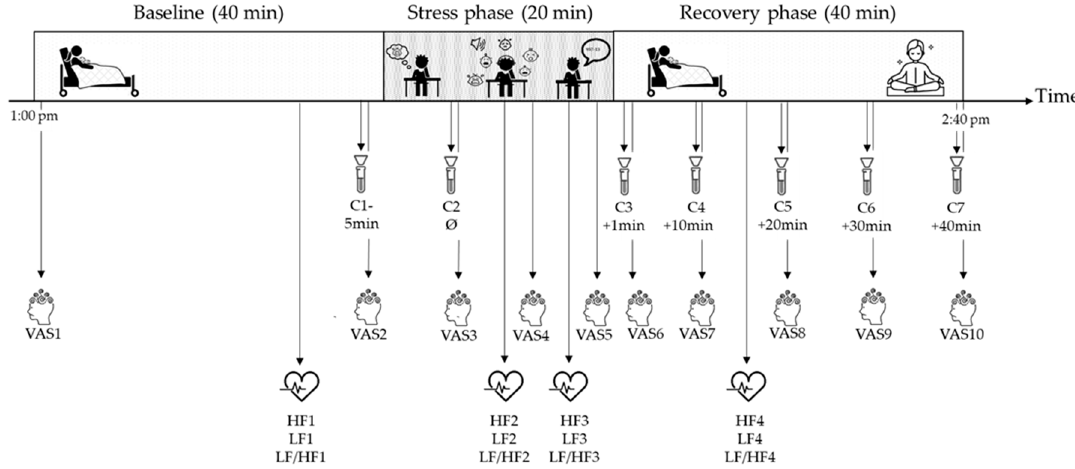
Figure 1. The procedure of the Lausanne Infant Crying Stress Paradigm contains a baseline phase and recovery phase, in which participants rest in their hospital room with their baby, as well as a stress phase, in which participants complete three stressful tasks (i.e., 3 min anticipation of the infant crying test, the infant crying test, and a surprise mental arithmetic task) in a consultation room. At the end of the recovery phase, an optional guided relaxation is offered to participants. Salivary cortisol assessments are represented by salivette icons, with the 1st salivary sample (C1) taken 5 min before the beginning of the stress phase, the 2nd salivary sample (C2) taken after the 3 min anticipation before the psychosocial and cognitive stressors, and the 3rd to 7th salivary samples (C3–C7) taken after the stress phase at 10 min interval. Perceived stress is illustrated with the head icon, measured 10 times via a visual analog scale (VAS) ranging from 1 = not at all stressed to 5 = extremely stressed. Heart rate variability covering high-frequency (HF) power, low-frequency (LF) power, and LF/HF ratio is symbolized by the heart icon and is measured at four different time points.